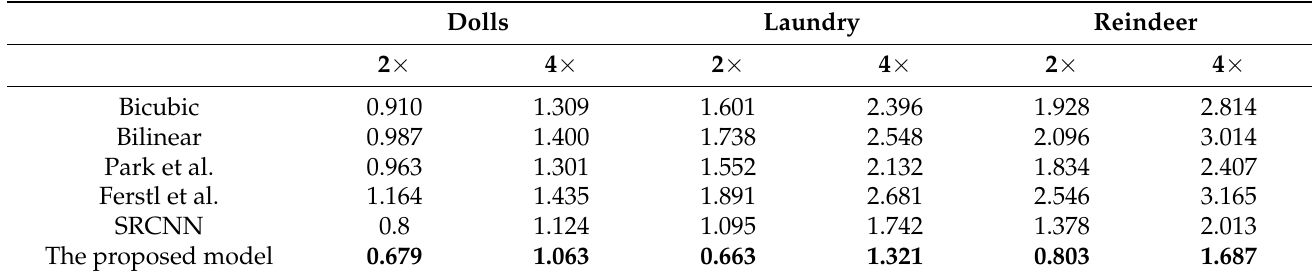
Table 2. Comparison of RMSE results of several methods